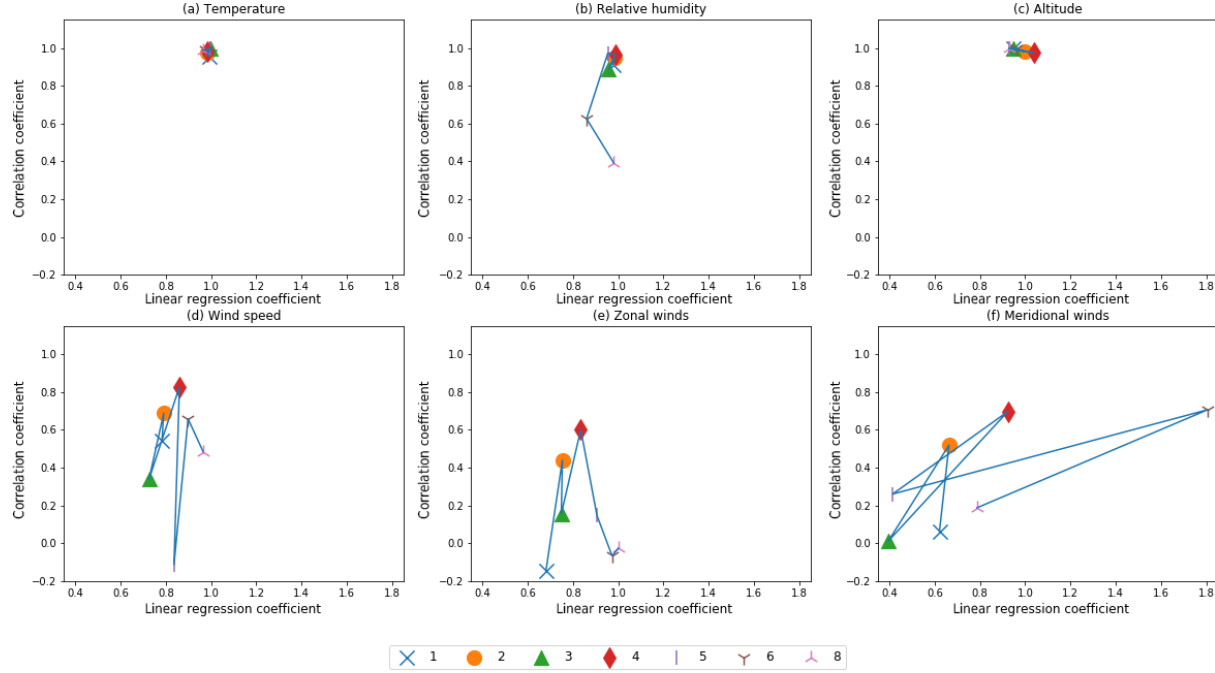
Figure 10. Comparison of the correlation coefficient and the linear regression coefficients between the S1H2 and the RS41-SG tempera- ture (a) , relative humidity (b) , altitude (c) , wind speed (d) , zonal winds (e) , and meridional winds (f) for all the flights where the S1H2 was used for the first, second, third, fourth, fifth, sixth and eighth